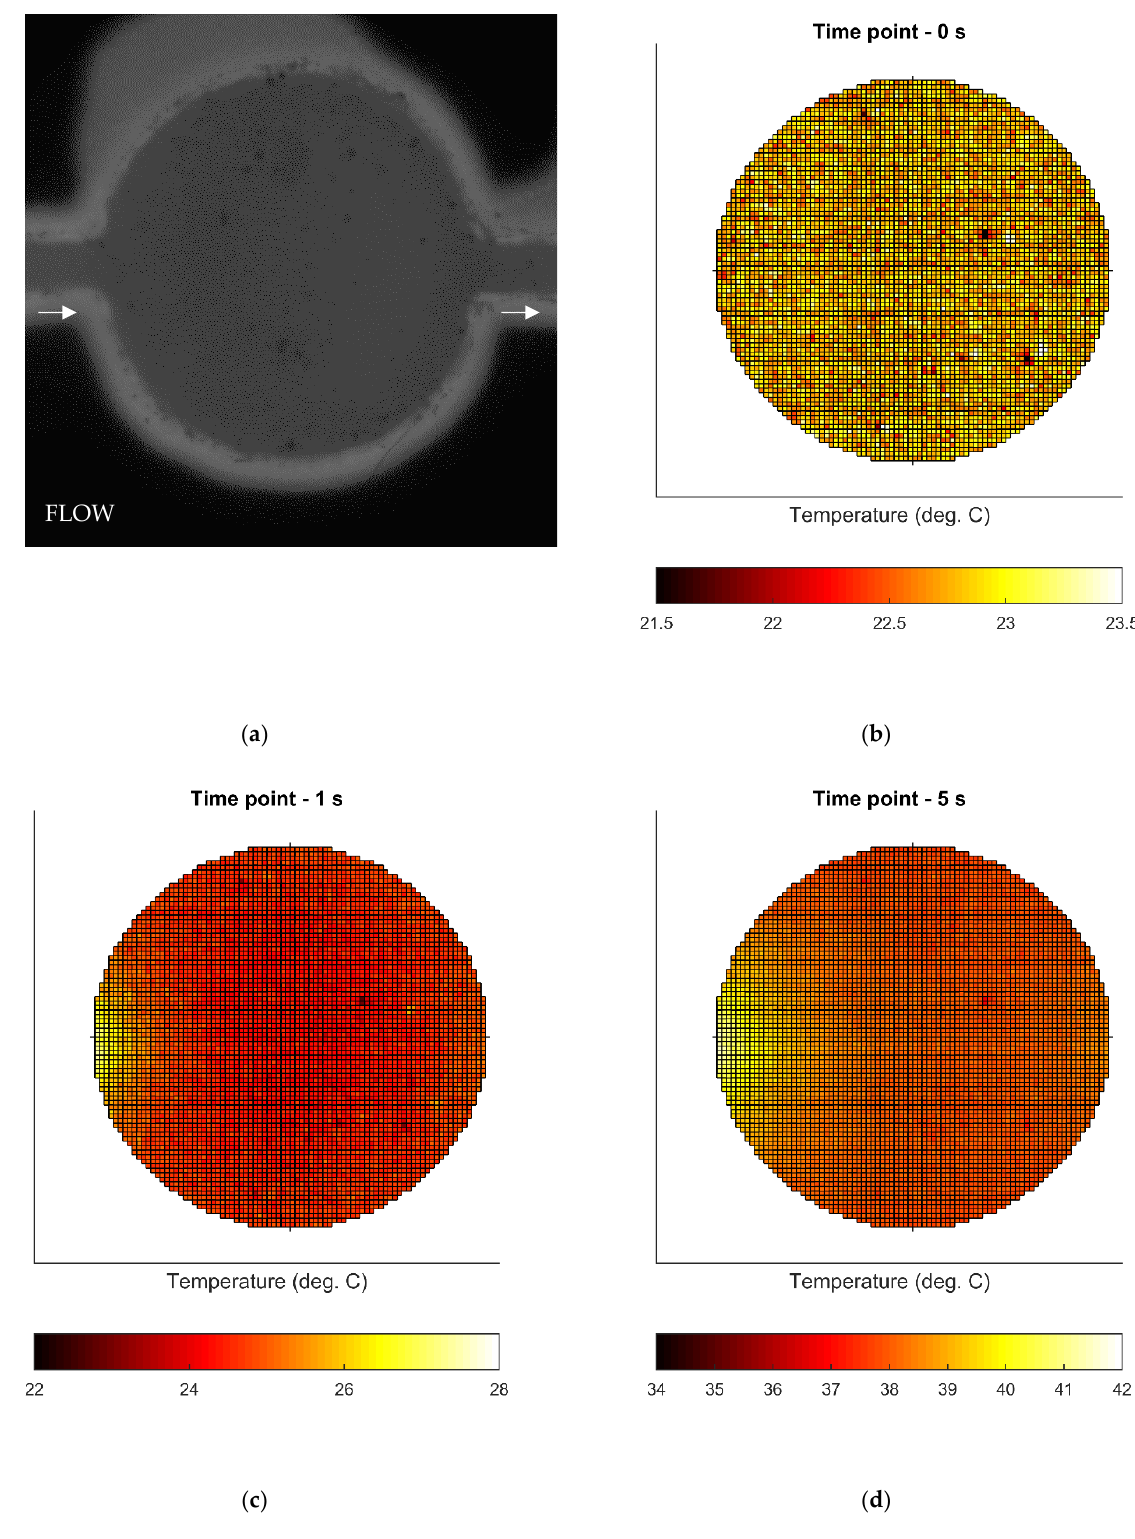
Figure 8. The 5 µL/min flow scenario. ( a ) The image of the fluorescent liquid loaded into the microwell before heating. ( b ) The temperature profile of the mixture in the microwell before heating. ( c ) The temperature profile of the mixture in the microwell after 1 s of the heating. ( d ) The temperature profile of the mixture in the microwell after 5 s of heating.